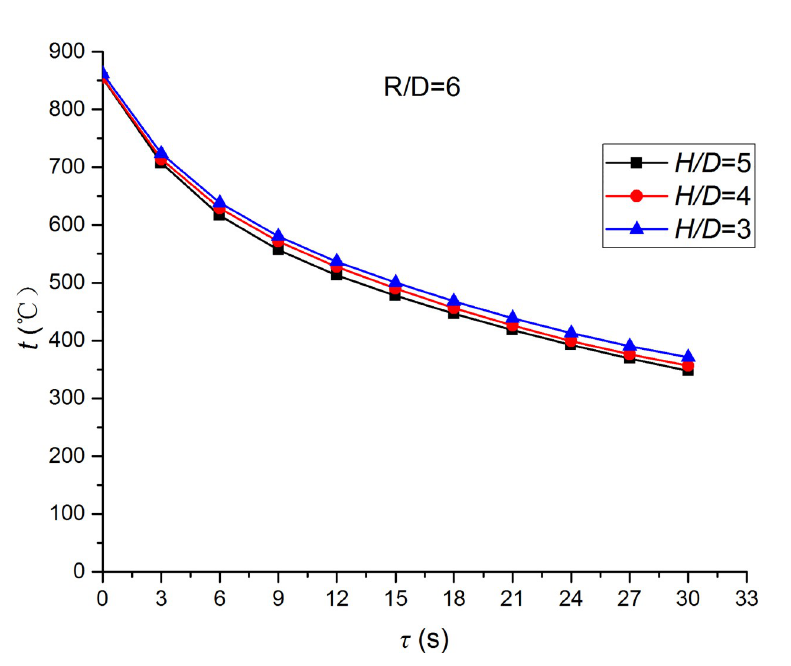
Fig 31. Surface temperature at R/D =